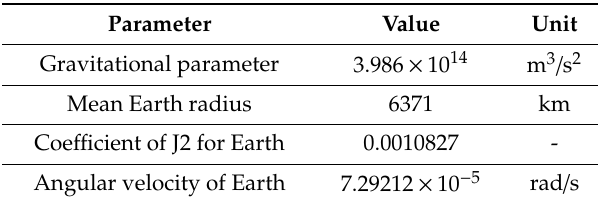
Table 4. Simulation constants.